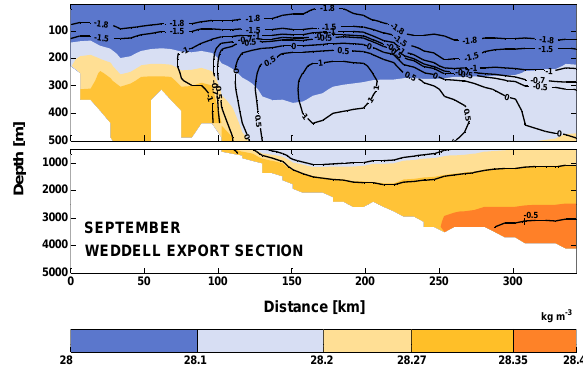
Fig. 3. Weddell Sea cross-slope section 1 fields of (colour) neutral density in kgm − 3 and (isolines) potential temperature in ◦ C of OC- CAM September climatology (1988–2004).